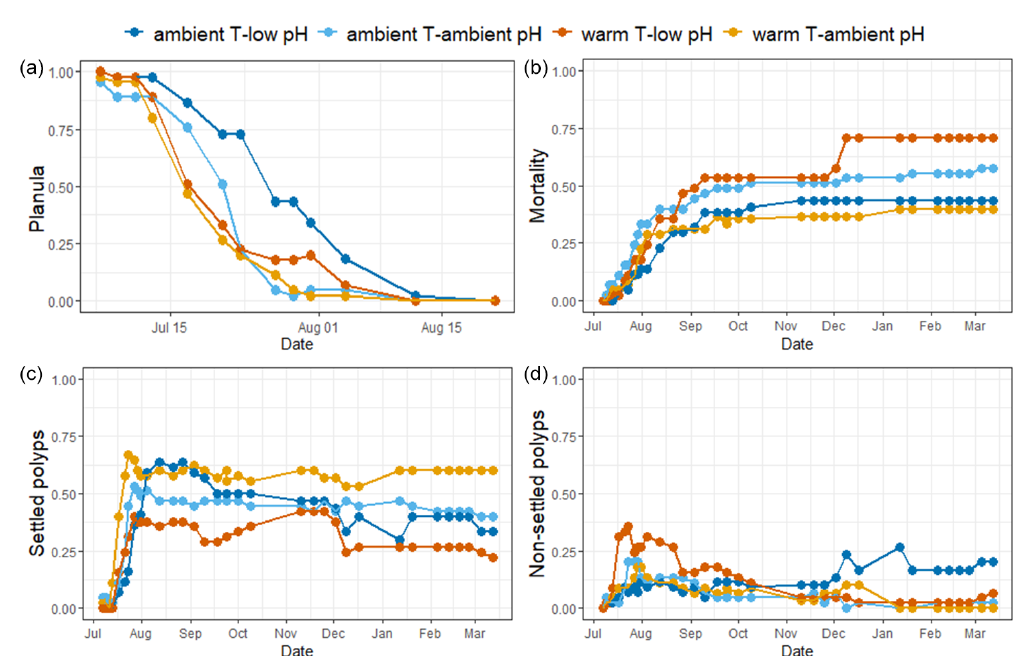
Figure 2. Proportions of four different stages of A. calycularis under the two temperature treatments (23 ◦ C for ambient temperature and 26 ◦ C for warm temperature) and the two pH treatments (pH T = 8 . 05 ± 0 . 09 for ambient pH and pH T = 7 . 78 ± 0 . 10 for low pH) during 9 months. (a) The proportion of planulas (swimming larvae), (b) the proportion of mortality (dead larvae and polyps), (c) the proportion of settled polyps (metamorphosed and fixed), and (d) the proportion of non-settled polyps (metamorphosed but not fixed). The proportion of non- settled polyps includes larvae metamorphosed into a free polyp and detachment of a settled polyp. n = 180 original larvae, three replicates per temperature and pH